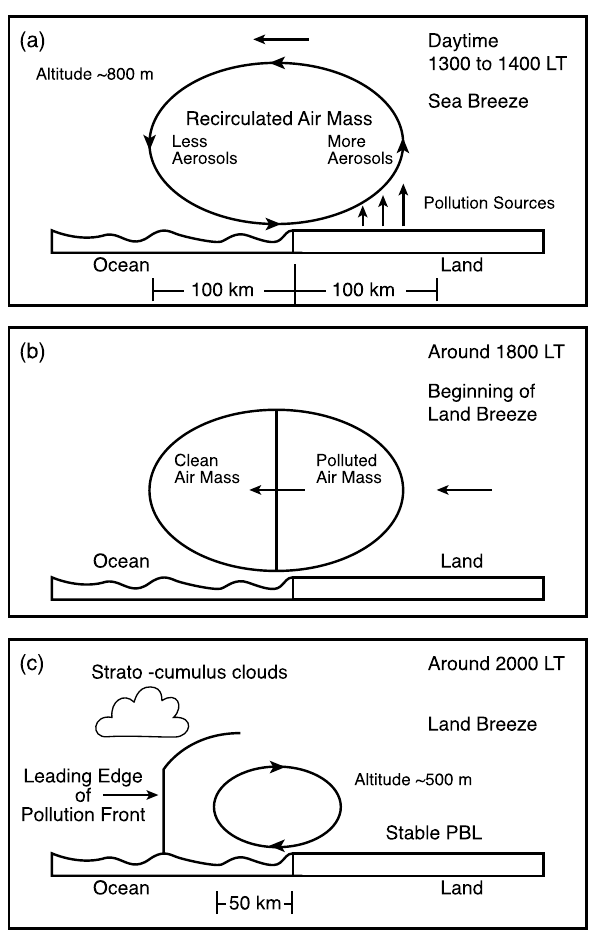
Fig. 20. Schematic of the mechanism leading to the strong pollution gradients in the MBL outflow: (a) the daytime situation, (b) evening transition, and (c) nighttime with the pollution front being advected offshore over the Indian Ocean (redrawn from Simpson and Raman, 2005, copyright 2005 by the Indian Academy of Sciences, repro- duced with